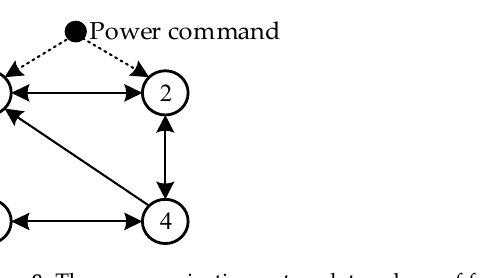
Figure 8. The communication network topology of fourdistributed BESS.